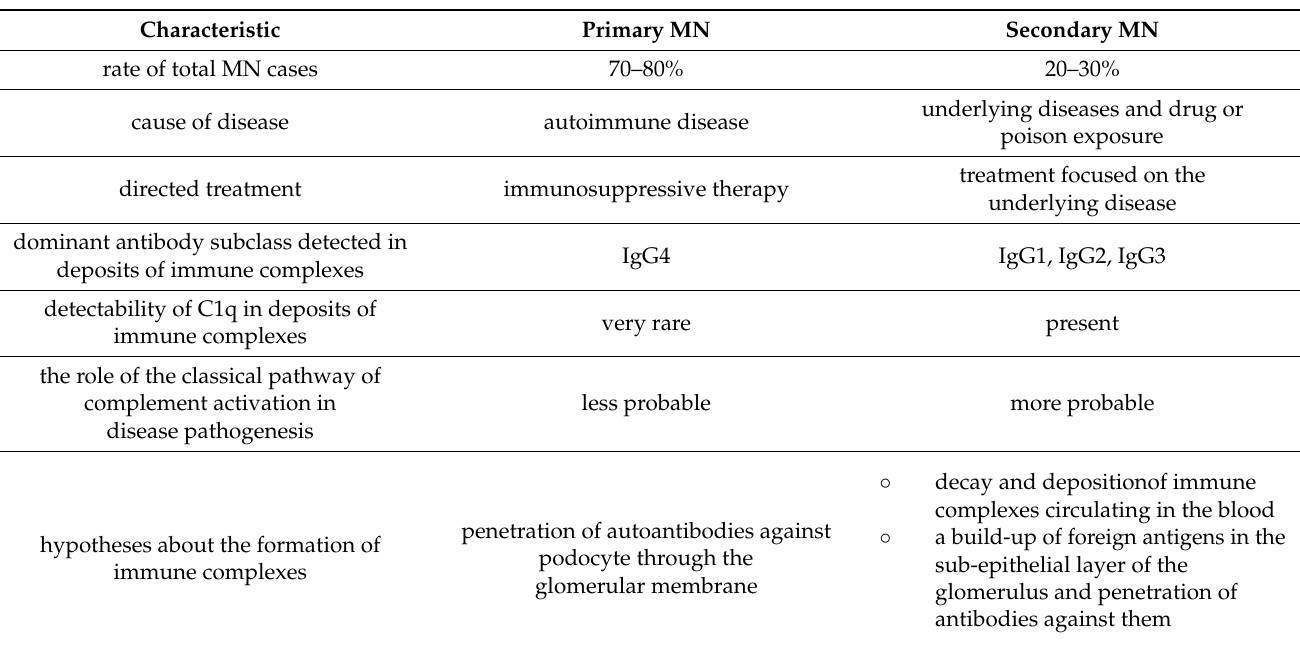
Table 1. Comparison between the primary and secondary forms of membranous nephropathy